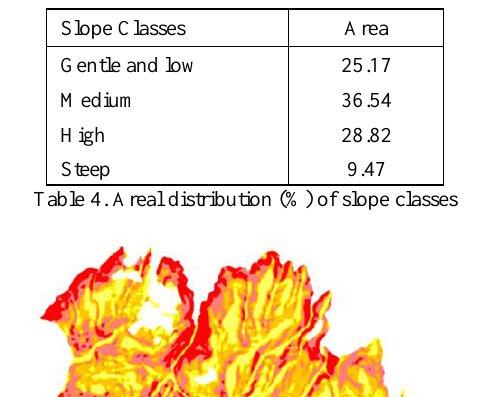
Table 6. The weighted values of soil